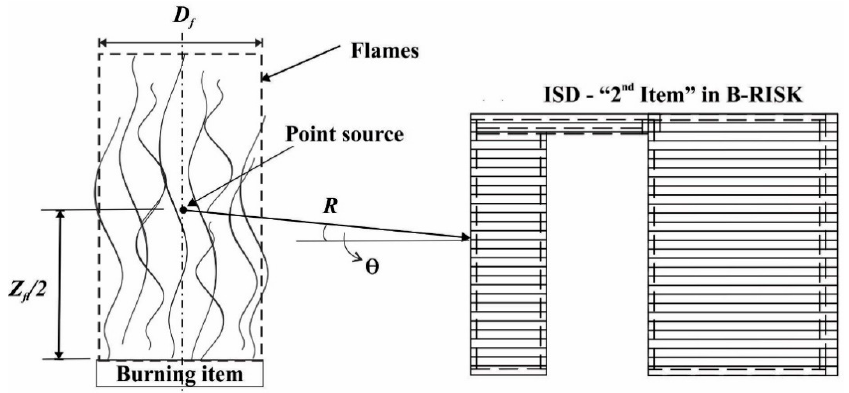
Figure 3. Point Source Method (PSM) geometry between the burning and target items [10]. Used with permission from Elsevier.